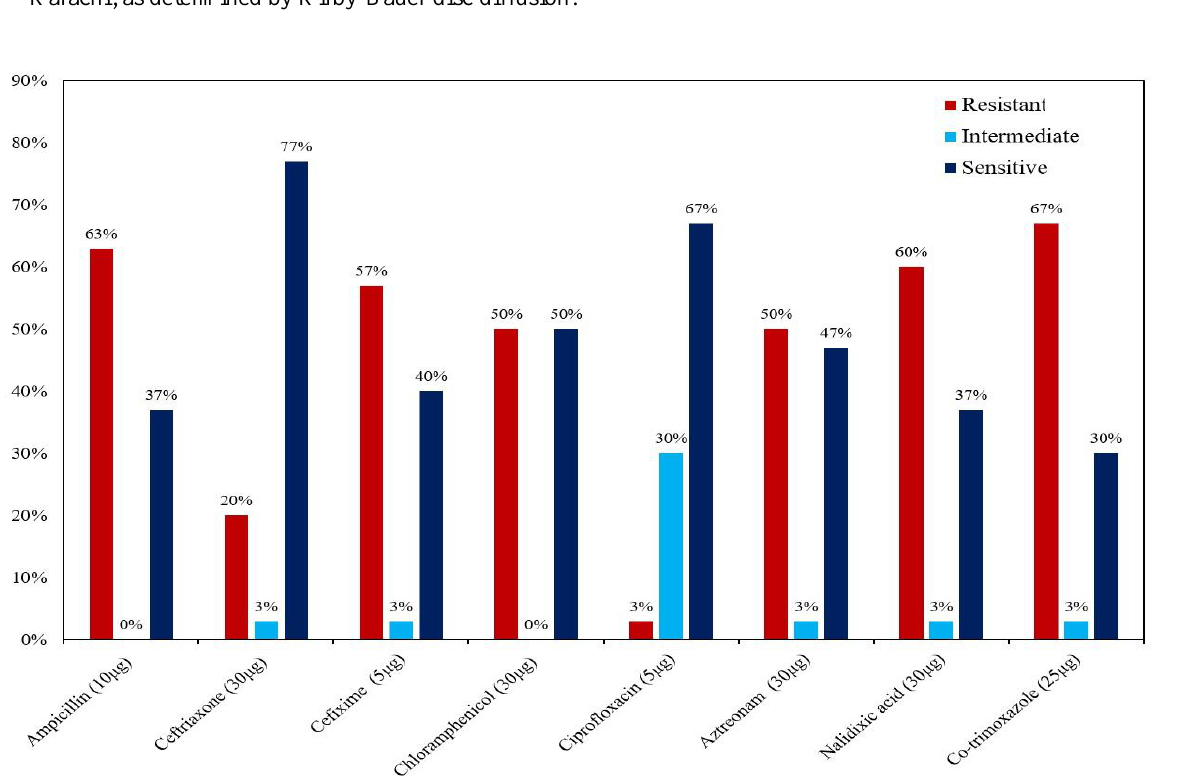
Figure 1. Susceptibility to first-line antibiotics of S. Typhi isolates collected from children in Gadap Town, Karachi, as determined by Kirby-Bauer disc